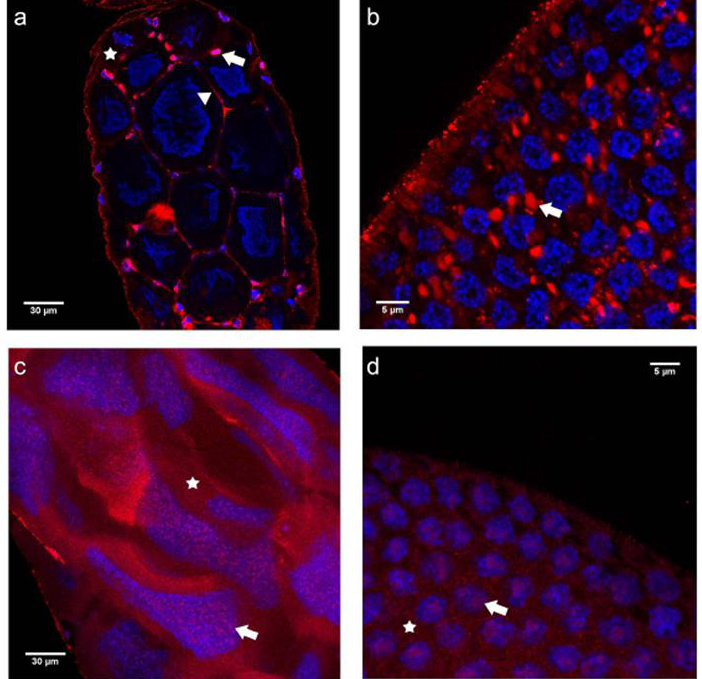
Figure 3. Immunofluorescence analysis with the antibody raised against the N-terminal domain of N-cadherin (N-cadN) performed on ovaries of egg-laying queens ( a and b ) and queenless workers ( c and d ). Shown are single confocal section images of 1 (cid:541) m thickness taken on vitellogenic follicles. ( a ) The trophic chambers of vitellogenic follicles in a queen ovariole showed N-cadN in association with plasma membranes (arrowhead) of large nurse cells and a nuclear signal in somatic follicular epithelium cells (arrow). The nuclear and cytoplasmic signals for N-cadN in nurse cells were weak. ( b ) The follicular epithelium covering the oocyte of queen vitellogenic follicles revealed N-cadN agglomerates in the cytoplasm (arrow). ( c ) Trophocytes of vitellogenic follicles of a worker ovariole showed a highly dispersed N-cadN labeling throughout the cytoplasm (asterisk), as well several nuclear foci (arrow) in these germline-derived cells. ( d ) A similar dispersed distribution pattern for this cadherin moiety was also seen in the cytoplasm (asterisk) and nuclei (arrow) of follicular epithelium cells covering oocytes. N-cadN immunoreactivity is shown in red, counterstained nuclei are in